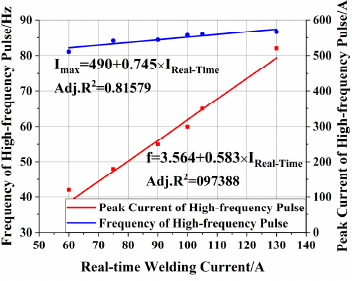
Figure 9. Peak current and frequency of pulses with different welding currents.